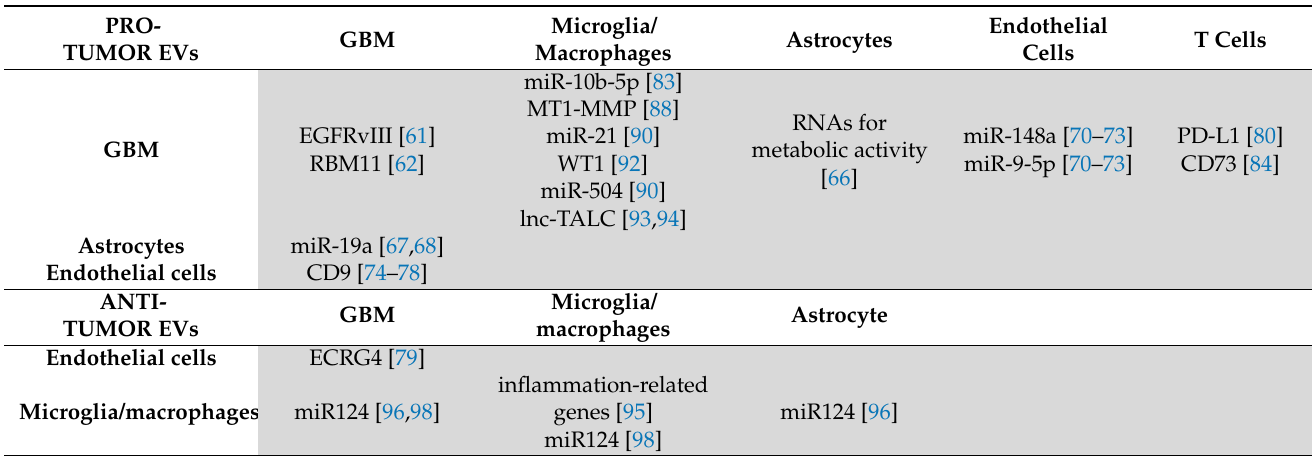
Table 2. Pro- and anti-tumorigenic factors transported by EVs in glioma microenvironment. Donor cells are listed in columns and target cells in